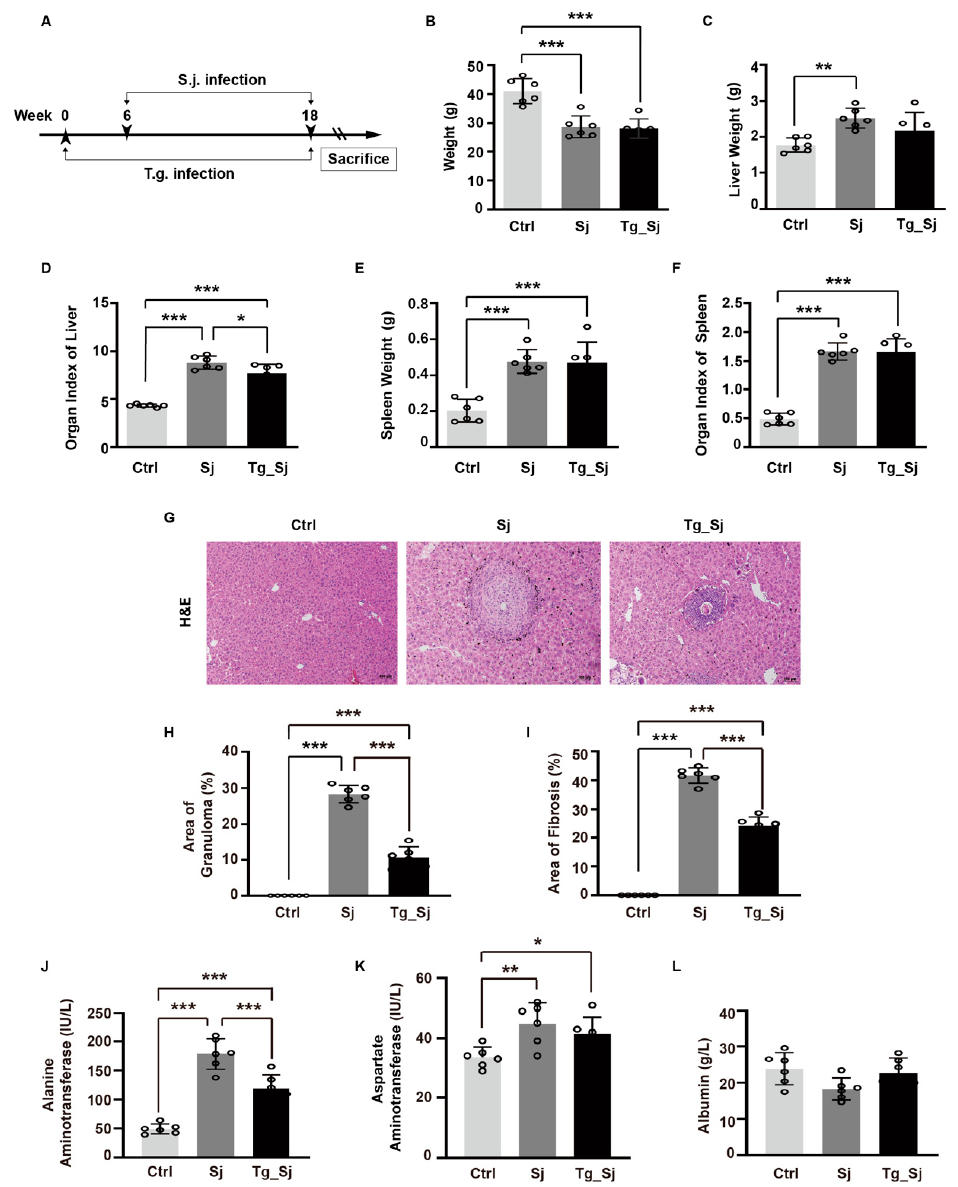
Figure 1. Co-infection of Toxoplasma gondii ( T. gondii ) and Schistosoma japonicum ( S. japonicum ) lead to decreased liver function. ( A ) Infection scheme of the mice model. Female ICR mice were infected with T. gondii six weeks before S. japonicum infection. Mice were sacrificed 18 weeks after the primary T. gondii (Tg) injection. ( B ) Body weight (BW) and organ weight coefficients of mice. ( C , E ) Liver and spleen weight of mice in control (Ctrl), S. japonicum (Sj)-infected and co-infected (Tg_Sj) groups. ( D , F ) Liver and spleen index (organ weight/BW) of mice. ( G ) Representative hematoxylin and eosin (H&E) staining datas were shown in liver sections (scale bar, 100 μ m). ( H ) The sizes of granulomas and ( I ) quantification of fibrotic area areas around a single egg were measured. The percentage of Sj and Tg_Sj group to the control group was calculated. ( J , K , L ) Albumin and serum aspartate aminotransferase, alanine aminotransferase levels were analyzed by automatic biochemical analyzer. Results are representative of at least three independent experiments (B-L, n = 6, one-way ANOVA). * p < 0.05, ** p < 0.01, *** p < 0.001.